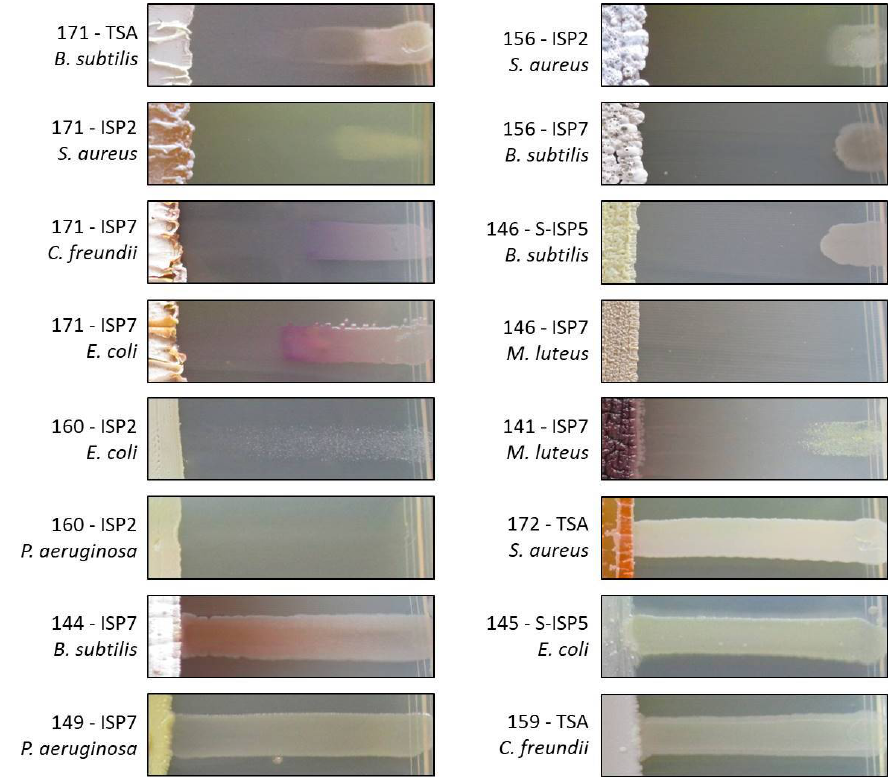
Figure 7. Selected representative examples of the cross-streak results. MMun strain numbers, media, and tested cultures are mentioned.